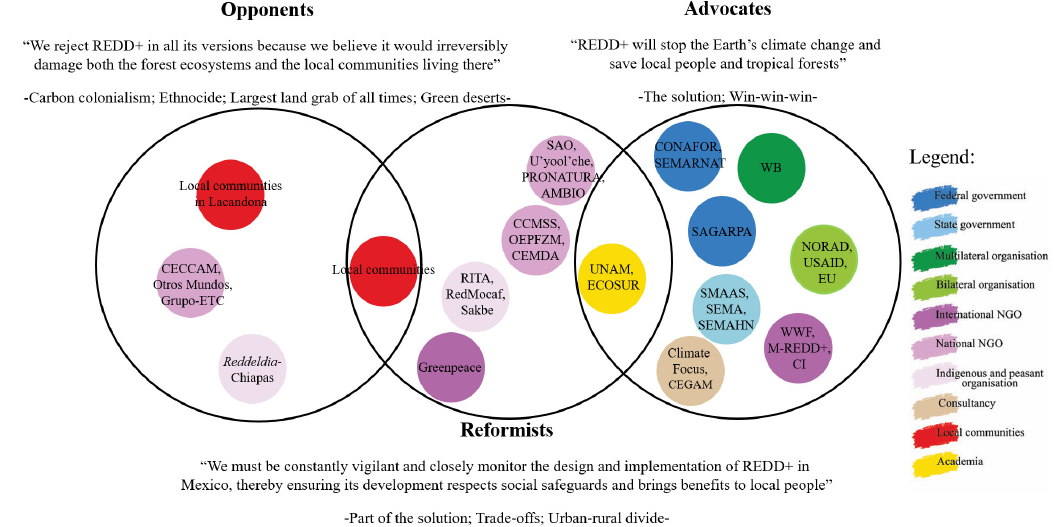
Figure 3. Composition (non-exhaustive) of the three REDD+ discourse coalitions in Mexico. The overlaps represent storylines on specific REDD+ issues shared between discourse coalitions. Each coalition is described by key metaphors and a quote paraphrased from interviews and documents to summarise the main storylines. Source: own elaboration.